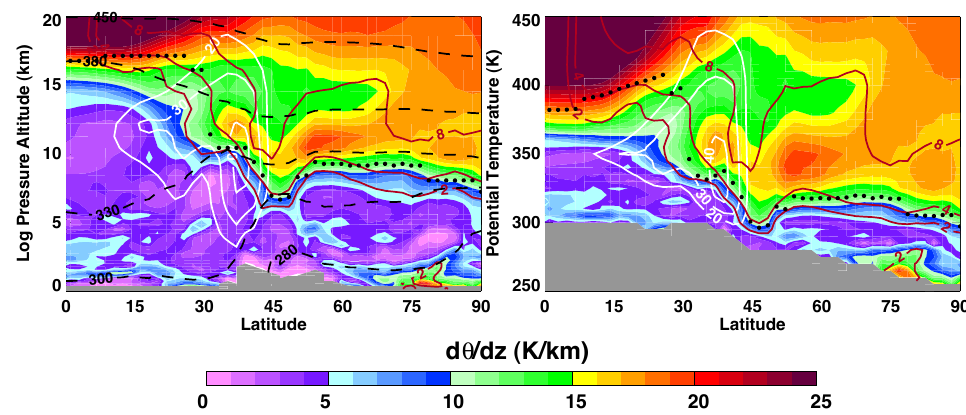
Fig. 5. An example of a latitude-height cross-section in Log-pressure altitude (left) versus potential temperature (right) coordinates. Colour images represent static stability (potential temperature lapse rate). Also shown are zonal wind speed (ms − 1 , white lines), PV (red lines) and the thermal tropopause (black dots). The cross-sections are along 120 ◦ W longitude. In the θ -coordinate the troposphere is a narrow layer, especially around the subtropical jet.